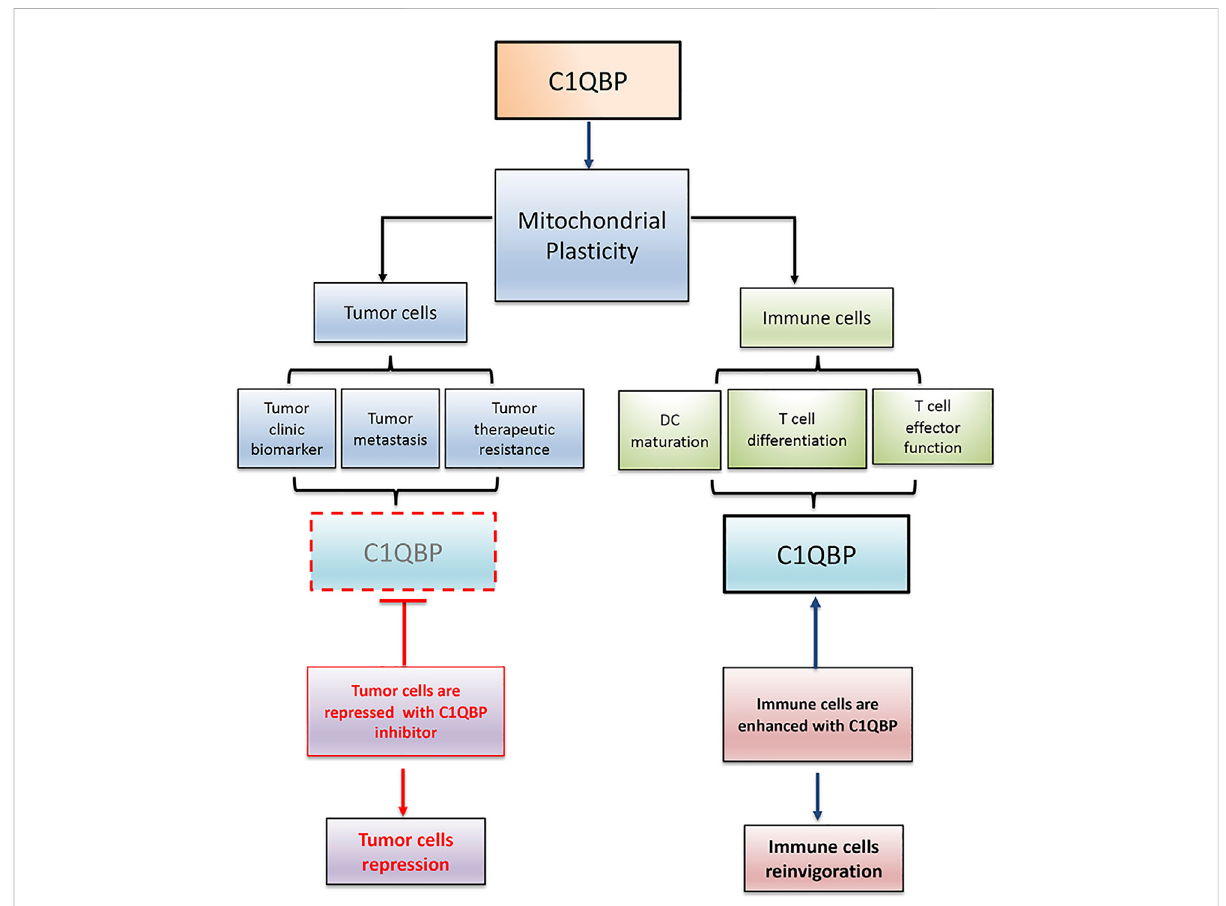
FIGURE 2 C1QBPregulationofmitochondrialplasticityaltersthecompetitive balancebetweentumorcellsandimmunecells. Tumorcellsdisarmed from C1QBP exhibit reduced tumor proliferation, metastasis, and therapeutic resistance, while immune cells potentiated with C1QBP perform the active and durable antitumor immunity. In this regard, strategic manipulation of C1QBP would repress tumor progression but optimize antitumor immune